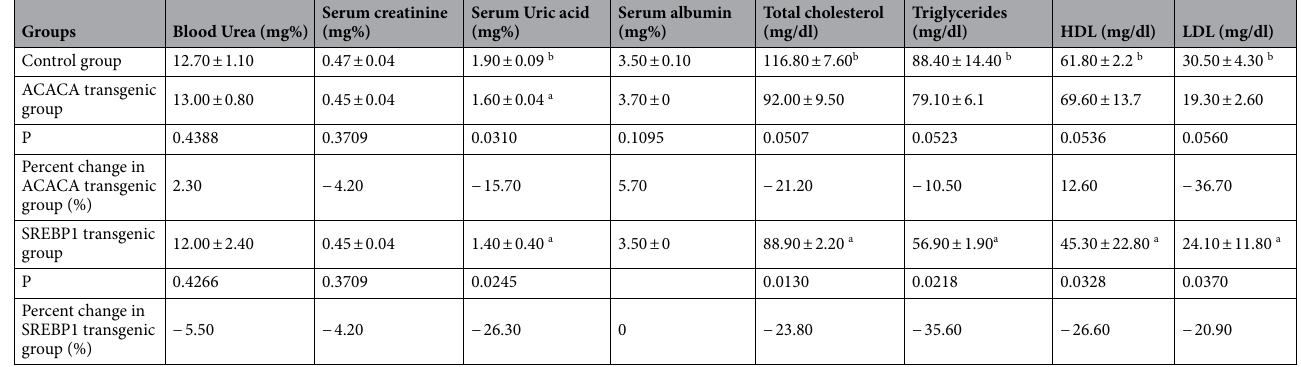
Table 6. Serum biochemical parameters (Mean ± standard deviation) such as blood urea, creatinine, uric acid, albumin, cholesterol, triglycerides, HDL and LDL contents in female transgenic (n = 2 for ACACA transgenic group and n = 2 for SREBP1 transgenic group) and control birds (n = 2) at 26 weeks of age during 1st generation. Different superscripts (column-wise) indicate significant differences. The serum biochemical parameters, which are indicators of overall health status of birds were compared between transgenic and control groups. The serum cholesterol, triglycerides and LDL contents were significantly reduced in transgenic groups as compared to the control group on account of silencing ACACA and SREBP1 genes in